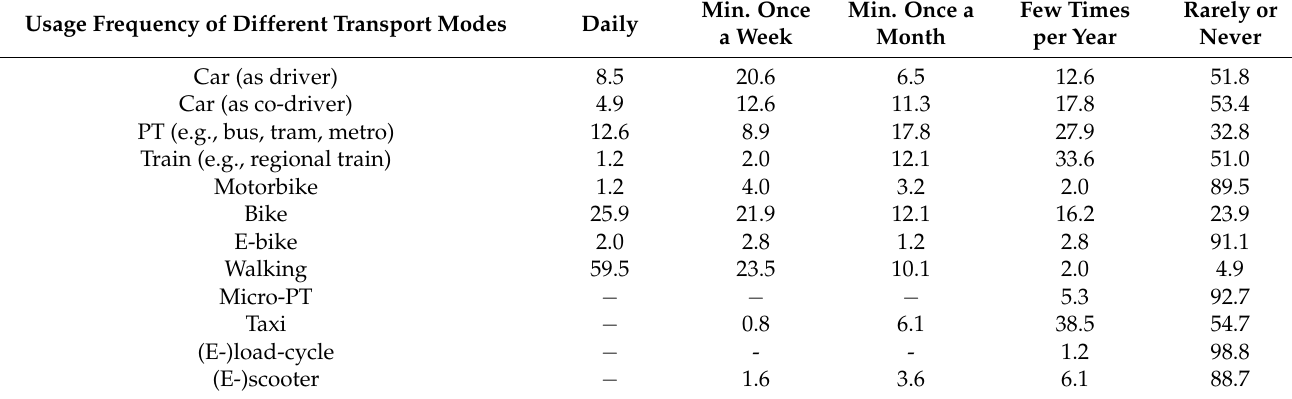
Table A4. Summary table for usage frequency of different transport modes (% of the respondents). Usage Frequency of Different Transport Modes Daily